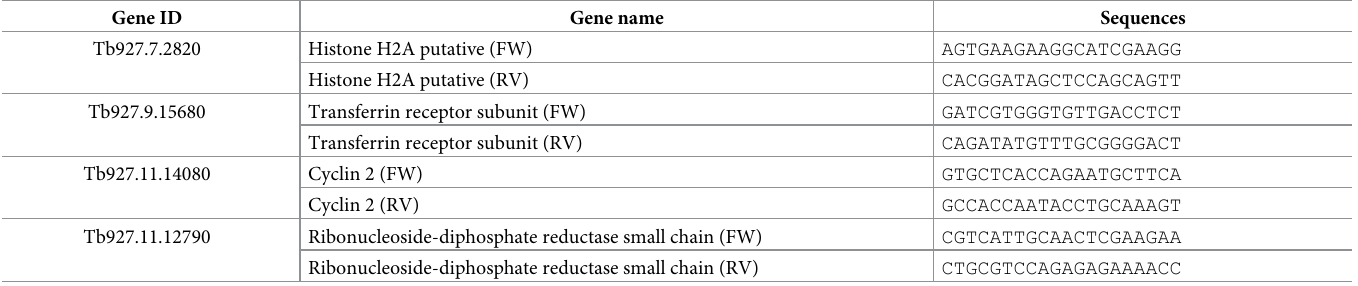
Table 1. Sequences of primers used of